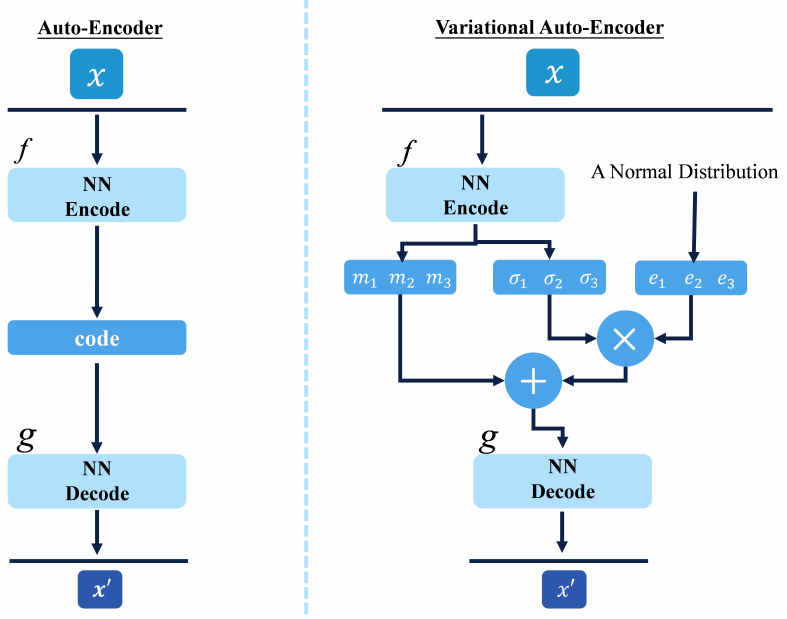
Figure 7. The comparison chart between AE and